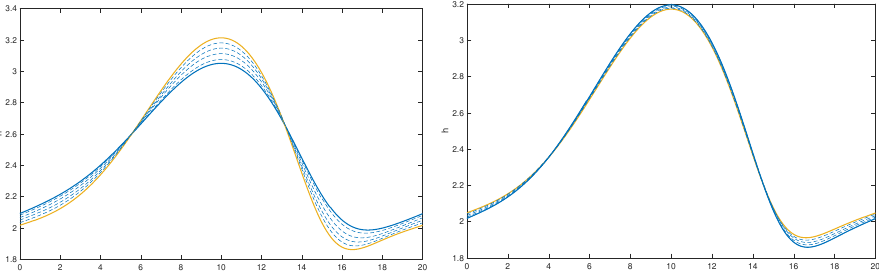
Figure 5. The left panel shows the dependence of the shape of the traveling wave on the parameter a 1 as we increase it from 0.1 (blue) to 1.25 (yellow) for fixed values h 0 = 2.5 and b = 11 in the laminar model with the non-dimensional velocity of the traveling wave decreasing from 1.338 to 1.331. The right panel shows the dependence of the shape of the traveling wave on the parameter b as we change it from 10 to 13 for fixed values a 1 = 1 and h 0 = 2.5 for the laminar flow model; the non-dimensional velocity of the traveling wave decreases from 1.34 to 1.32 in this